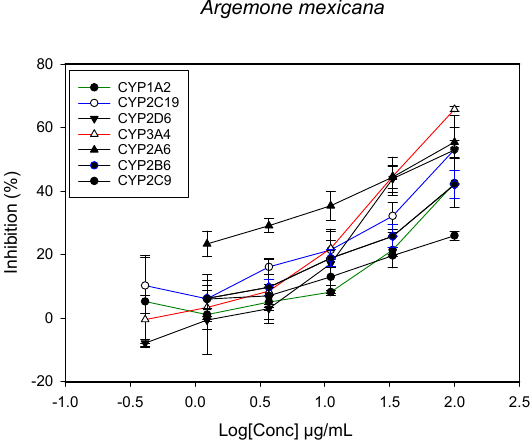
Figure 2. The inhibitory effect of graded concentrations of the extracts of A. mexicana on the metabolic activity of cytochrome P450 enzymes.